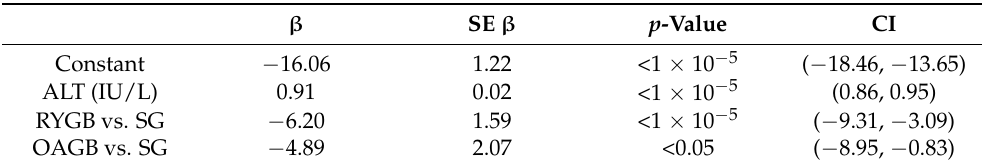
Table 3. Backwards elimination multivariate linear regression model for the change in ALT levels two years after bariatric surgery in patients with abnormal pre-surgical ALT levels.